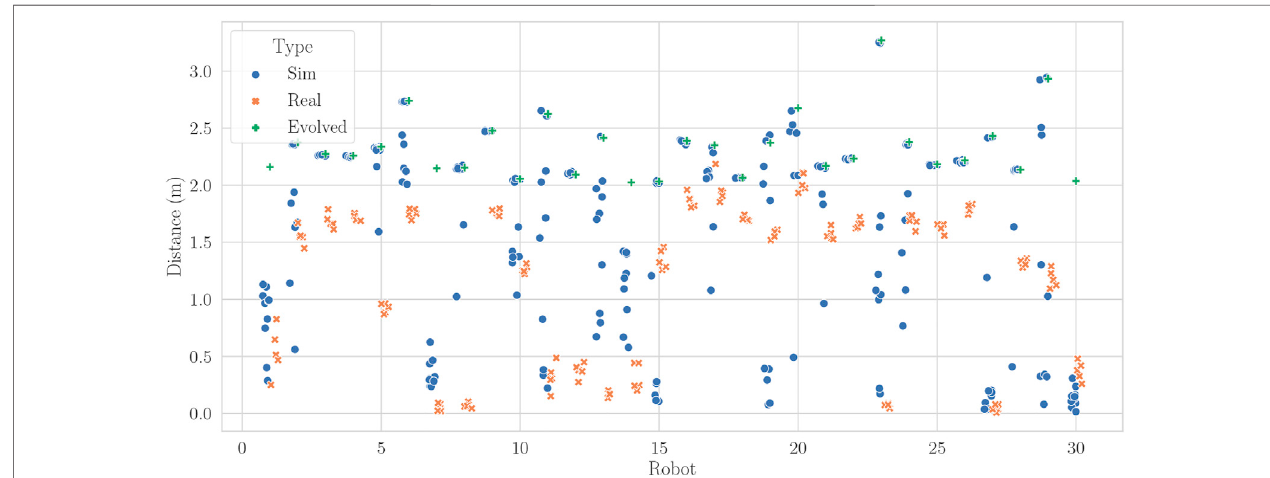
FIGURE8| Distancetraveled bytherobotsinreality (Real)and insimulation withnoise inthecontroller(Sim).We have alsoplottedthe originaldistancetraveled by the robot in its evolutionary run (Evolved).